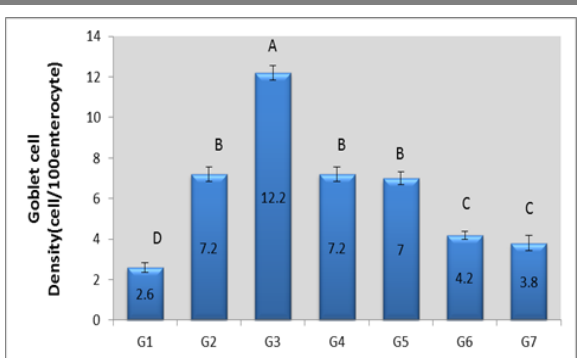
Figure 6. Effect Of PLGA Nps And PLGA Loaded with Different Concentration Of Peptide On goblet cell density (%).G1=received diH2O, G2= ordinary vaccine,G3=PLGA nanoparticle, G4= PLGA+160 µg peptide, G5=PLGA+80µg peptide,